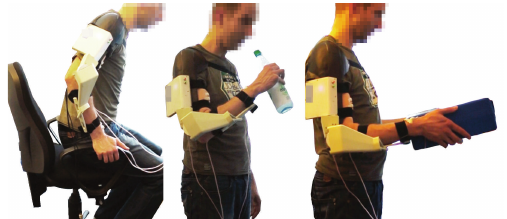
Figure 2: The patient is able to train independently various types of exercise of daily life. A special shoulder strap increases the stable seating of the orthosis, resulting in a better weight distribution.